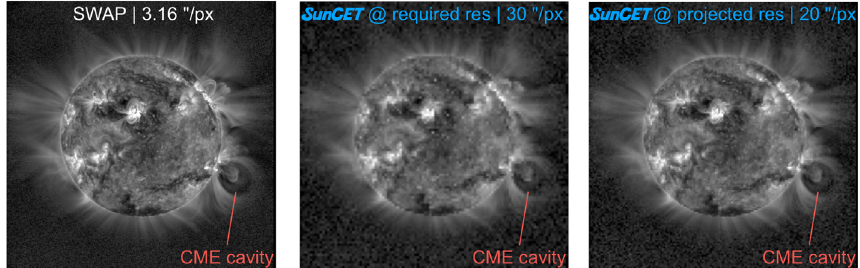
Fig. 7. CME cavity observed in PROBA2/SWAP 174 Å binned down to SunCET required resolution of 30 (projected performance is 20). The cavity remains easily identi fi able. SunCET ’ s SNR will be 9 – 30 (cid:3) higher off disk, making CME identi fi cation even easier. The 1.7 R (cid:1) FOV shown here, the largest of any solar EUV imager to date, is SWAP ’ s; SunCET ’ s extends to 4 R (cid:1) . Adapted from Byrne et al. (2014).